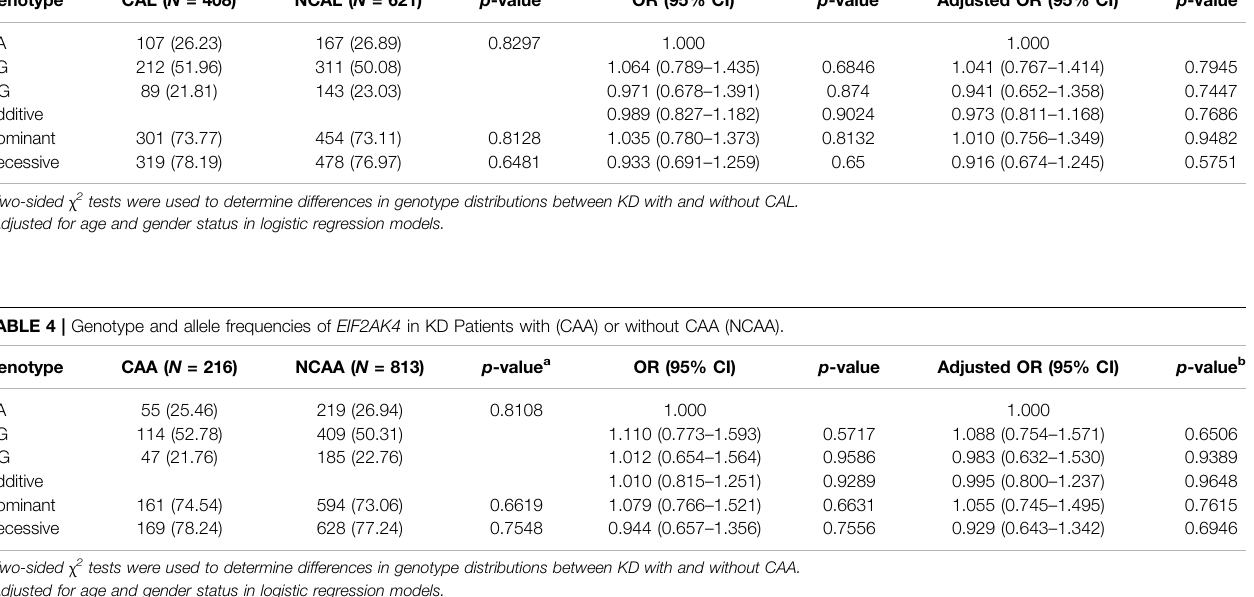
TABLE 3 | Genotype distribution frequency of EIF2AK4 /rs4594236 polymorphism in the NCAL group and CAL group of KD patients. Genotype